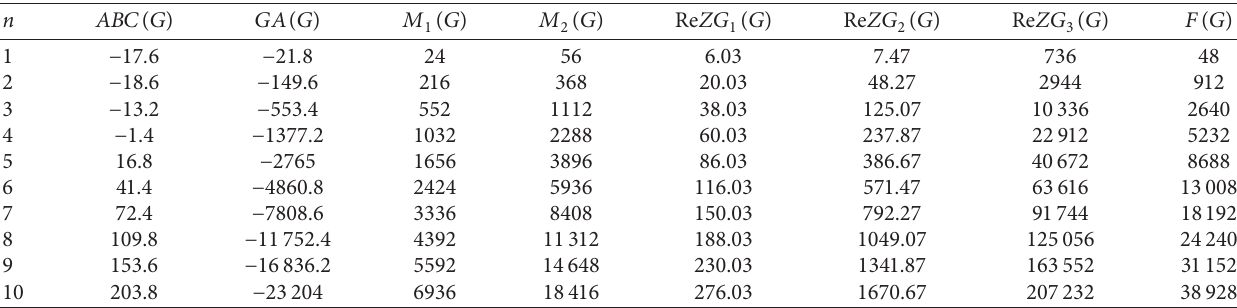
Figure 3: Three-dimensional graphical representation of degree-based topological indices. Table 2: Numerical comparison of Star of David network.